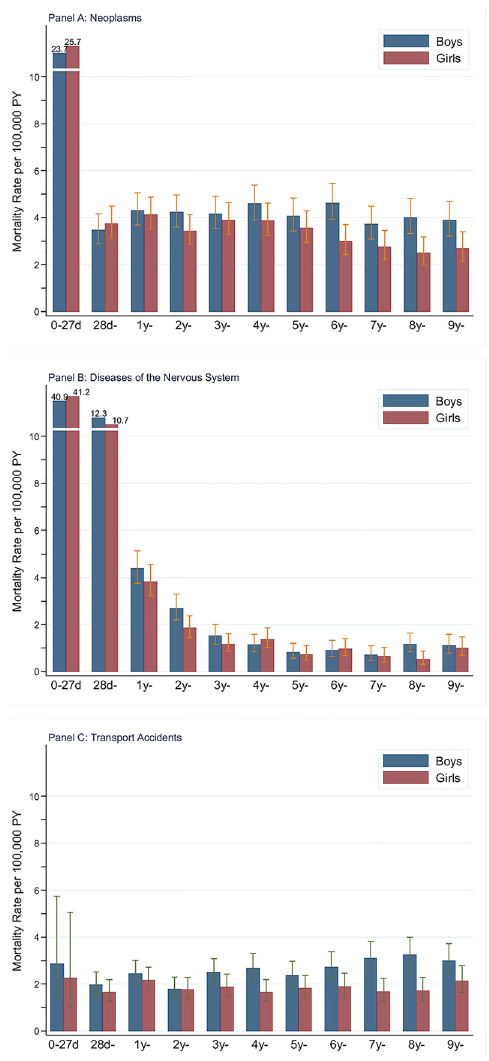
Fig 3. Mortality rates of the three most frequent causes in children aged 0 – 9 years over age and gender (28d: 28 – 364